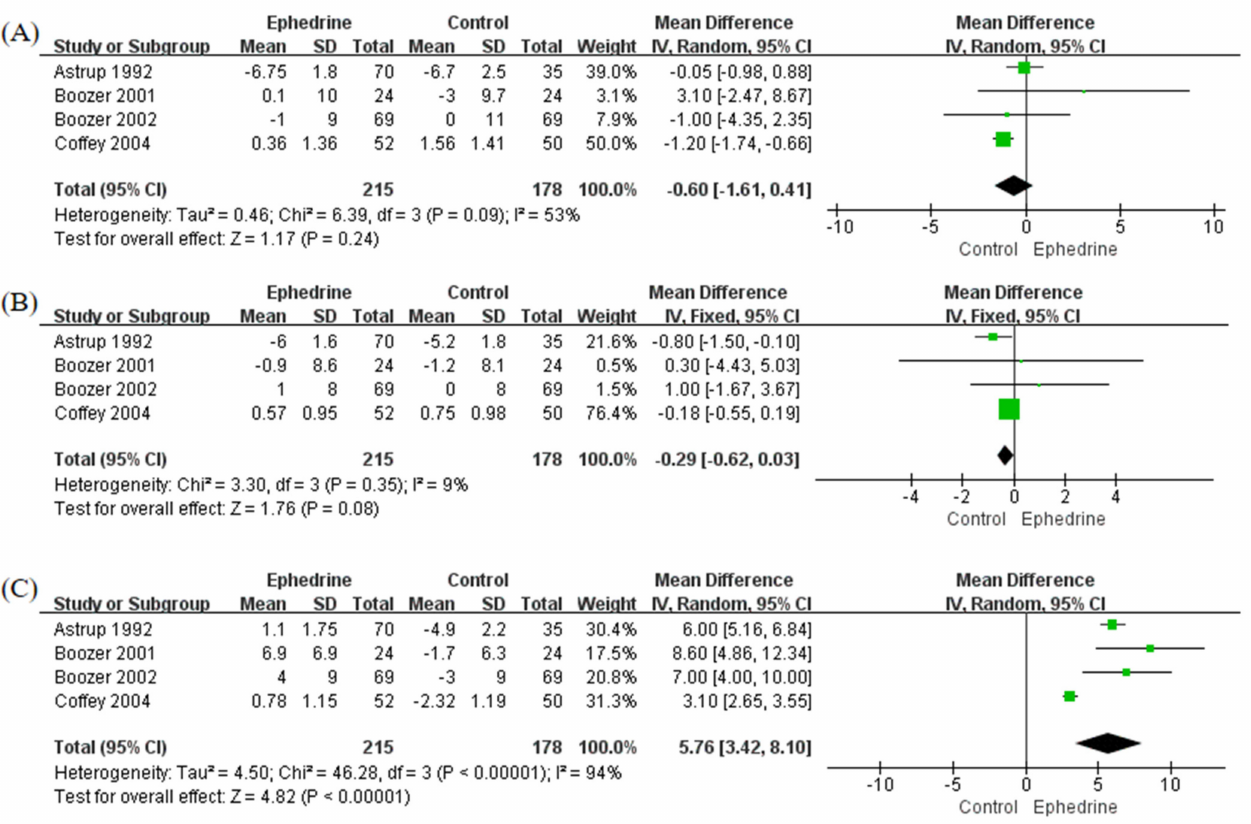
Figure 3. Forest plots to compare blood pressure and heart rate changes between ephedrine-containing products and placebo in obese or overweight patients. ( A ) Systolic blood pressure (mmHg); ( B ) diastolic blood pressure (mmHg); ( C ) heart rate